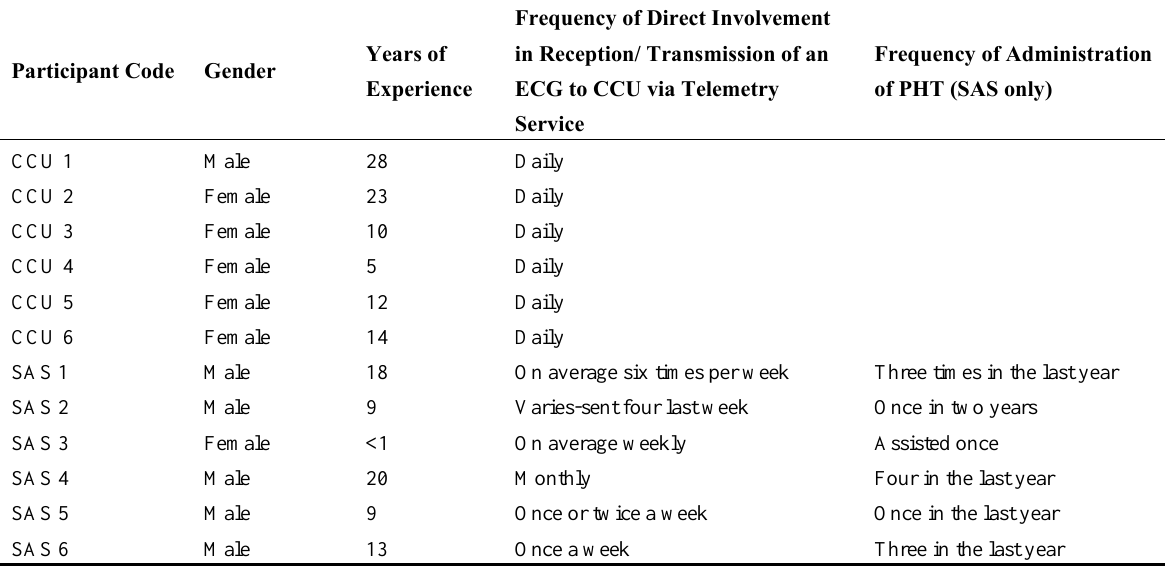
Table 5. Summary of the demographic data of the study participants and their involvement with the telemetry